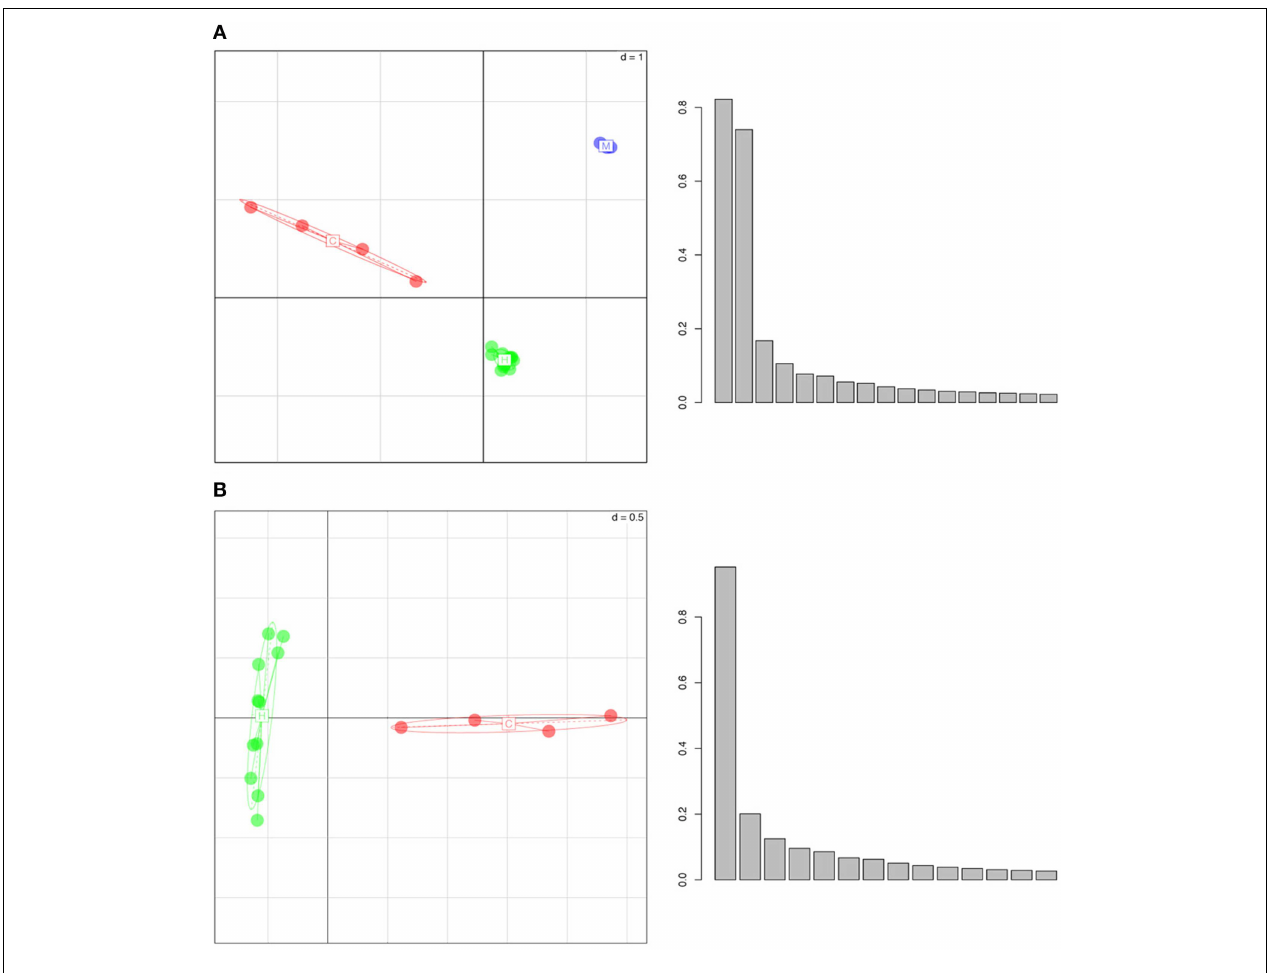
FIGURE 1 | Whole Genome Principal Component Analysis of peak density values for (A) humans (in green), chimpanzees (in red) and rhesus macaques (in blue), (B) humans (green) and chimpanzees (red). The individuals of each species group into well separated clusters,